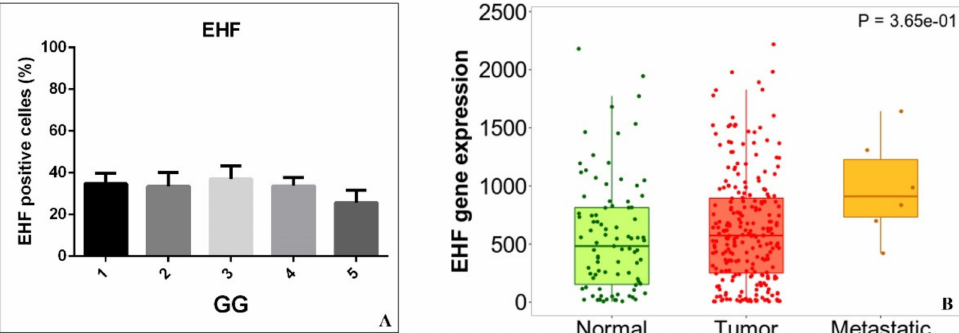
Figure 2. EHF expression, Gleason group (GG), and bioinformatics analysis. ( A ) The graph displays the percentage of EHF-positive cells in prostate cancer lesions classified according to the Gleason group (GG). ( B ) EHF gene expression in normal tissue, prostate adenocarcinomas, and prostate cancers that developed metastatic lesions